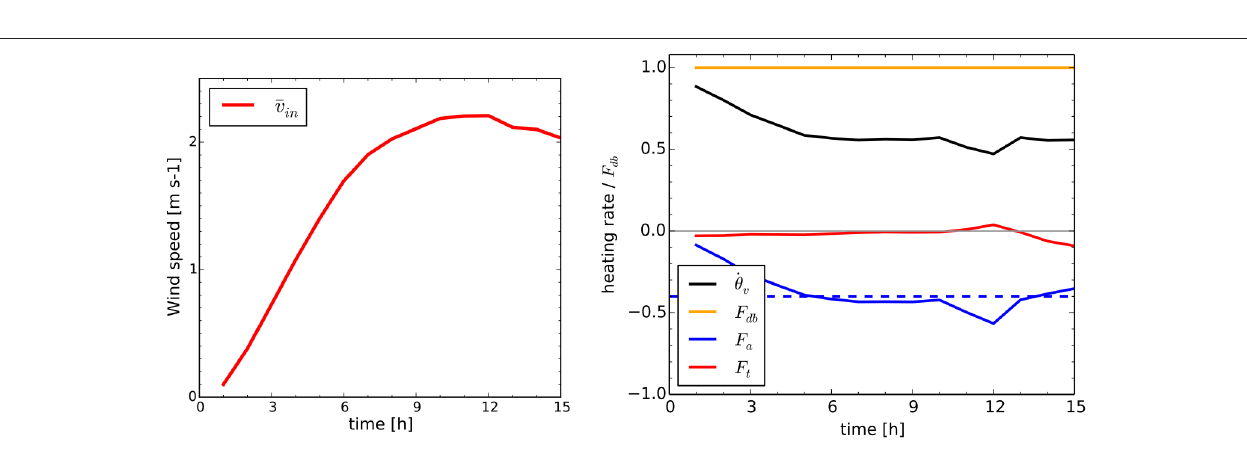
Frontiers in Earth Science | www.frontiersin.org